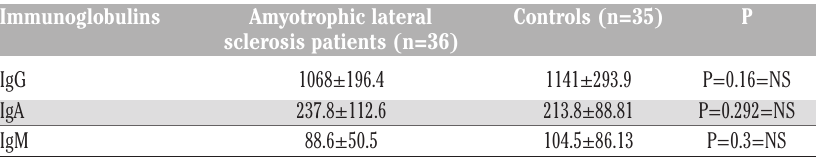
Table 1. Immunoglobulin levels in serum (mean±standard deviation) of amyotrophic lat- eral sclerosis patients and controls. Immunoglobulins